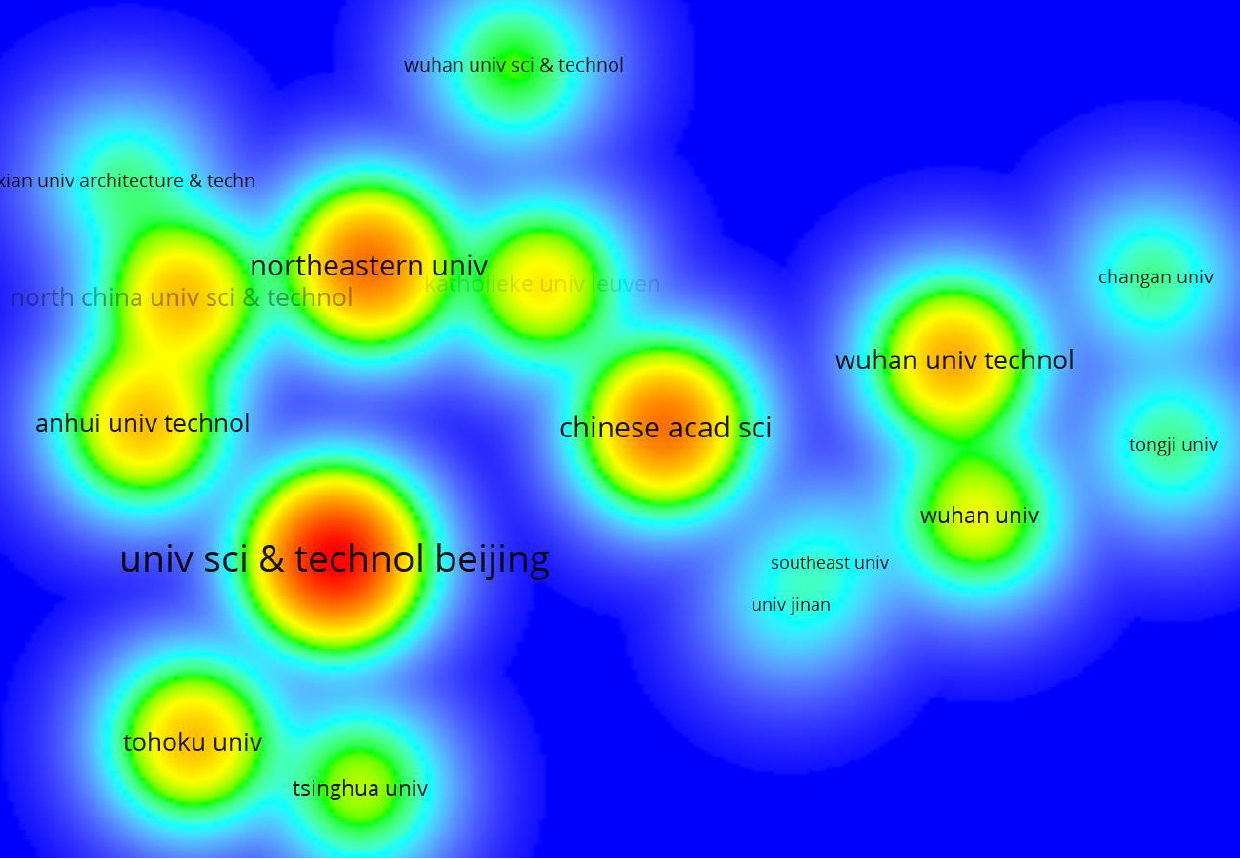
Figure 8. Cooperative density diagram of institutions in the research field of steel slag.